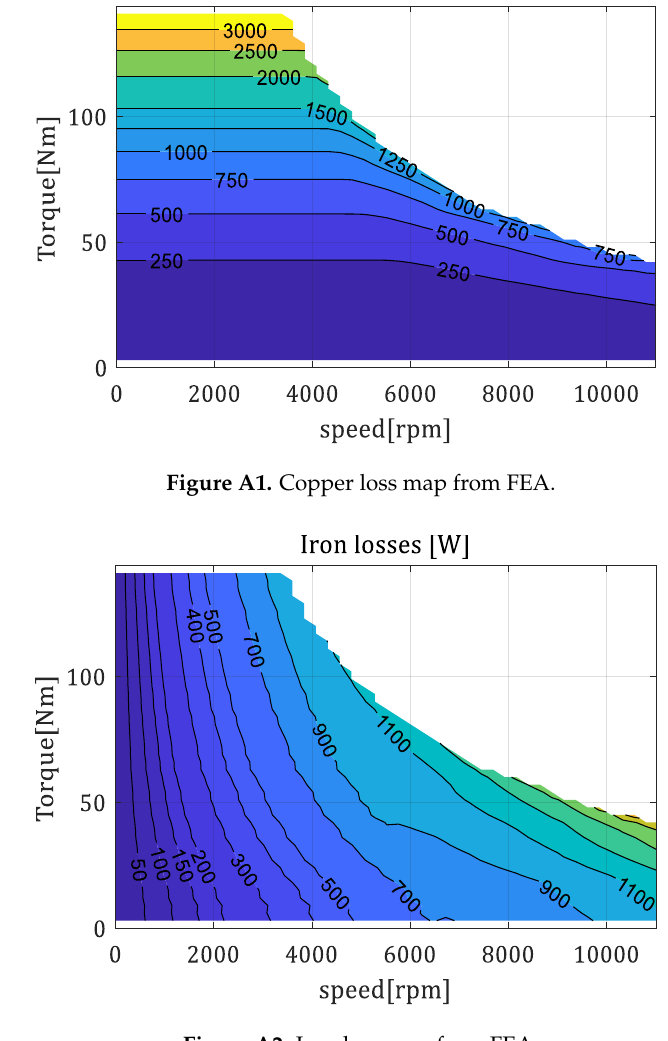
Figure A2. Iron loss map from